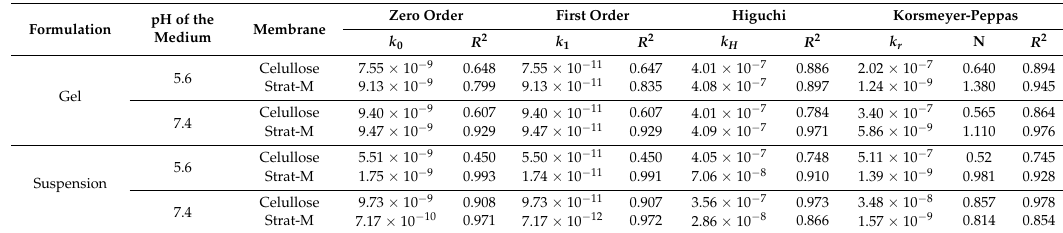
Table 4. Kinetic study for KTP permeation through cellulose and Strat-M ®